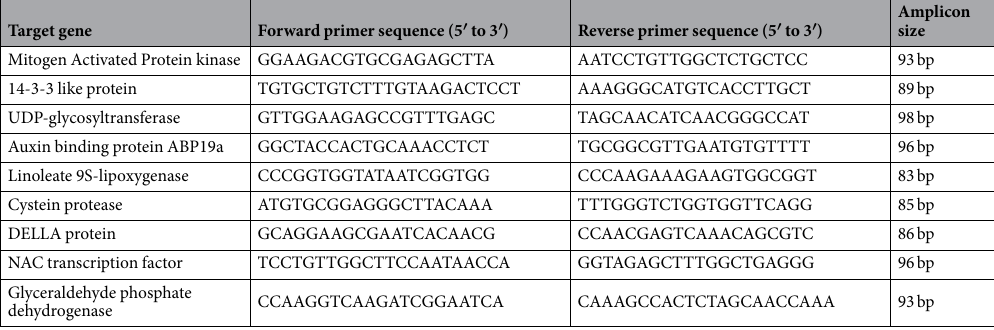
Table 4. Primer sequences of the defense related genes of chickpea and GAPDH (used as a reference gene) used for qRT-PCR.